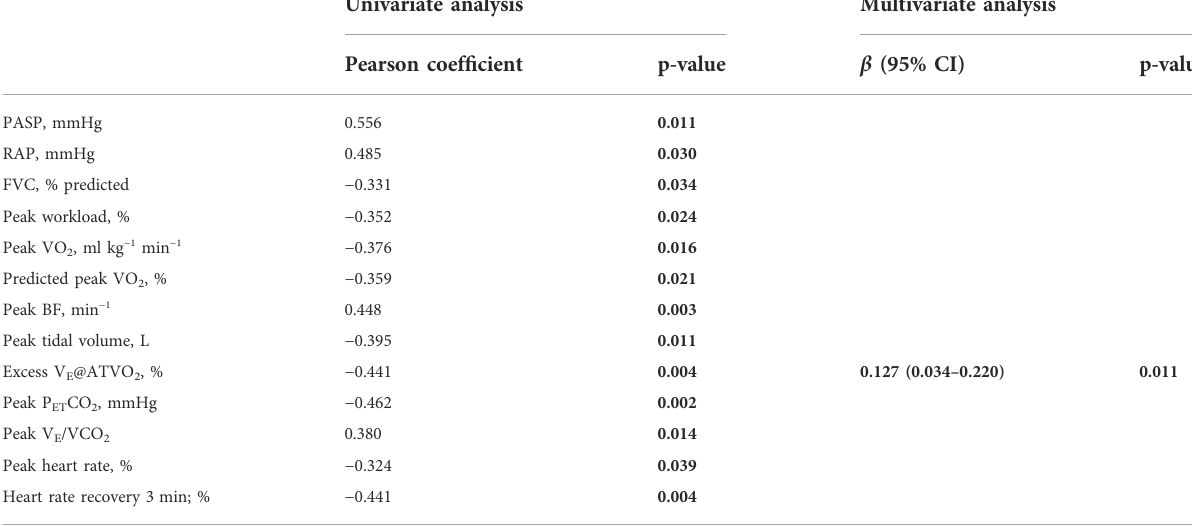
TABLE 2 Univariate and multivariate analysis of relationship between ventilatory inef fi ciency and main characteristics of cardiac ATTR amyloidosis patients ( n = 41). Univariate analysis Multivariate